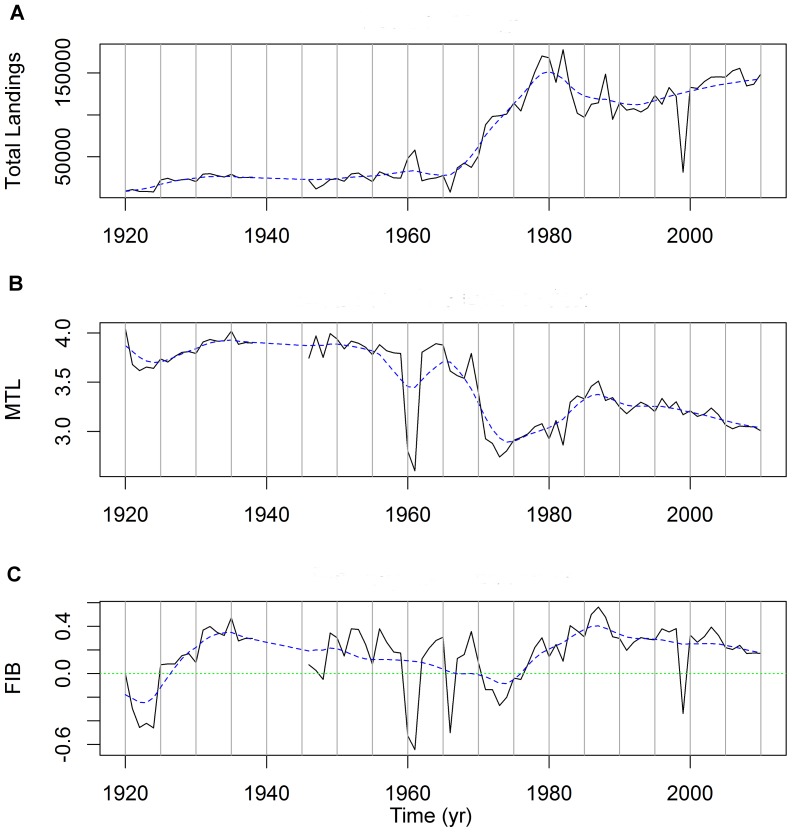
ICES data for the English Channel on landings, mTL and FiB index for 1920–2010.Analysis excludes pelagic species. (A) Annual landings from the English Channel. (B) Changes in the mTL over time. (C) Changes in the FiB index over time. The blue dashed line is a smoothing function, “supsmu” [50] available as standard with the R software package [51].